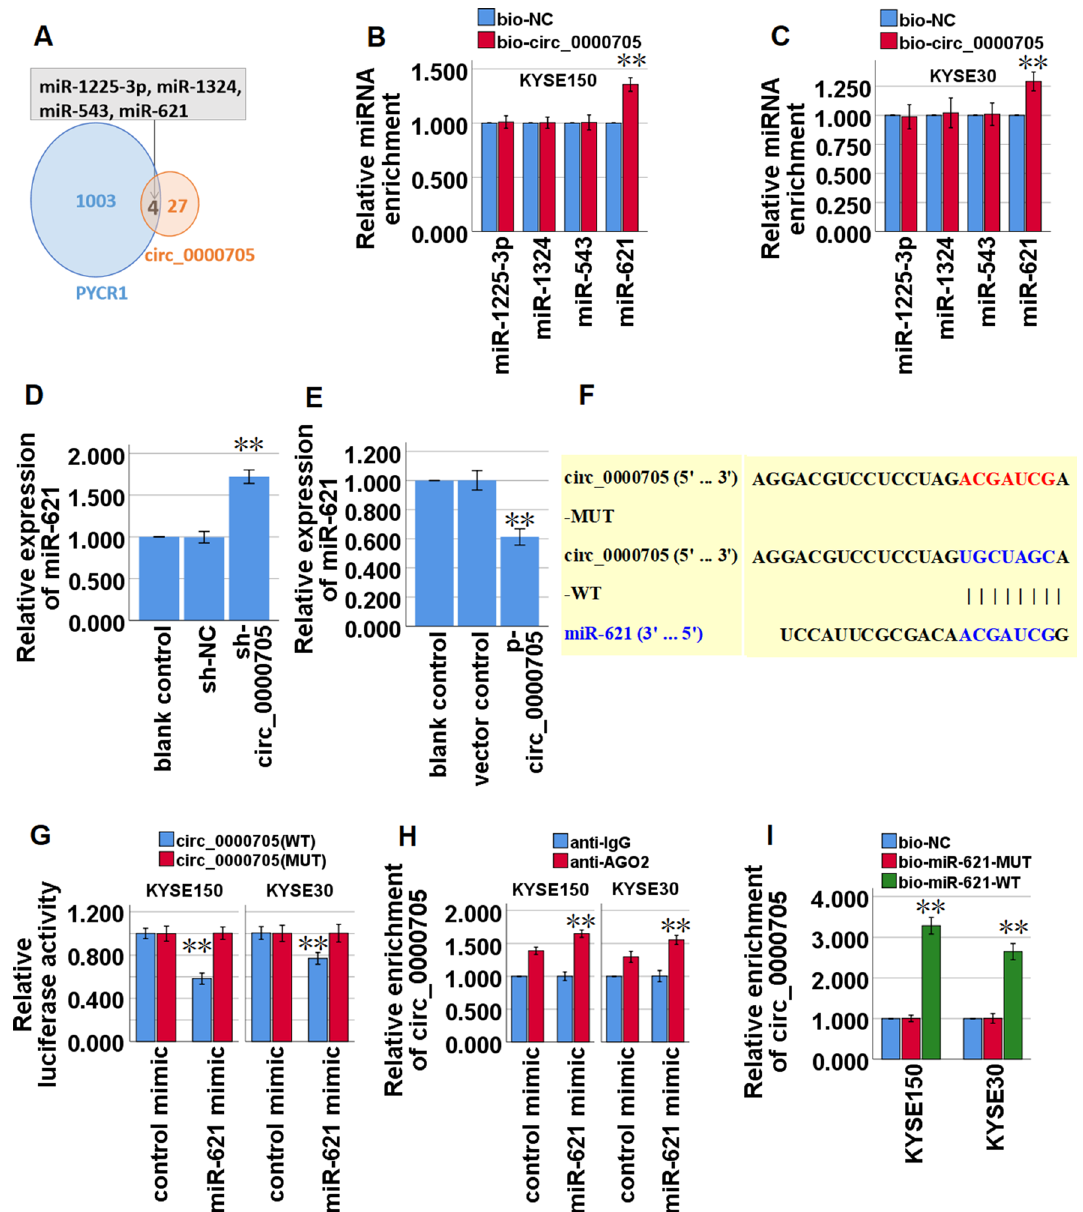
Fig. 4 Circ_0000705 binds to miR-621 and inhibits miR-621 expression in ESCC cells. A Venn diagram was used to screen the mutual miRNAs for circ_0000705 and PYCR1 mRNA. B , C The most probable miRNA target was analyzed by RNA pull-down assay with bio-circ_0000705 in KYSE150 and KYSE30 cells. D The expression of miR-621 was detected by qRT-PCR in KYSE150 transfected with sh-circ_0000705 or sh-NC. E The expression of miR-621 was detected by qRT-PCR in KYSE30 transfected with p-circ_0000705 or the vector control. F Bioinformatics anal- ysis suggested that miR-621 might share the binding sites with circ_0000705. The wild-type and the mutated sequences of circ_0000705 (mutation site: red). G The luciferase activity of KYSE150 and KYSE30 cells was detected in luciferase reporter plasmid containing wild-type circ_0000705 (circ_0000705-WT) and mutant circ_0000705 (circ_0000705-MUT) co-transfected with miR-621 mimics or negative control (control mimics). H AGO2-RIP followed by qPCR to detect circ_0000705 level in KYSE150 and KYSE30 cells after miR-621 over-expression via miR-621 mimic. I The cell lysate was incubated with biotin-labeled miR-621, and circ_0000705 expression was measured by qPCR in the products of pull-down by biotin-labeled WT miR-621 or MUT miR-621 in KYSE150 and KYSE30 cells. ** P < 0.05, and ** P < 0.01 vs